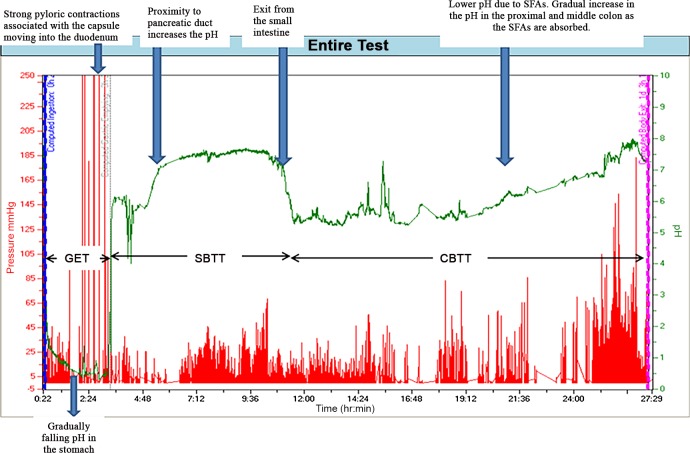
Record of variation in pH and pressure over time obtained by a wireless motility capsule in a healthy female after consumption of the placebo solution.The X axis represents time and the Y axis represents pH in green and pressure in red. Gastric emptying is indicated by a sharp rise in pH of > 4unit at 3 h and 21 m. Entry into the caecum is indicated by a drop in pH of 1 unit at approximately 10 h 35 m after the time of ingestion of the wireless motility capsule (WMC). The drop in temperature at 27 h and 24 m indicates the exit of the WMC. GET = Gastric emptying time; SBTT = Small bowel transit time; CBTT = colonic transit time; SCFA = short chain fatty acids.